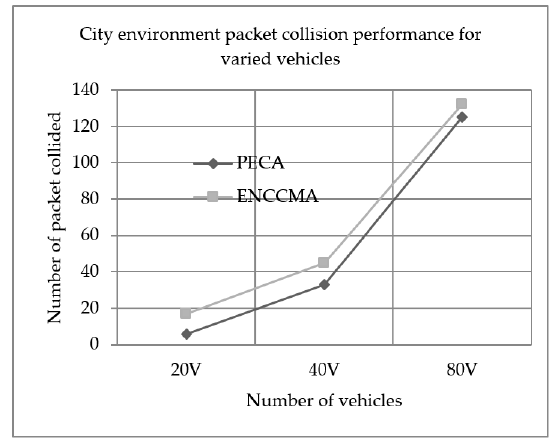
Figure 7. City environment packet collision performance for varied vehicles.